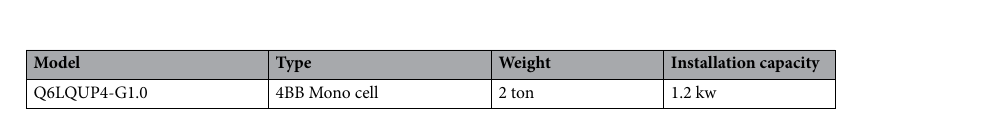
Table 1. Land use plan in environmental impact statement. The plant has an installed capacity of 40 MW, equipped with approximately 130,000 solar panels. Maximum Power Pmax (W) per panel (300 W): Standard Test Conditions, STC, a cell temperature of 25 °C, and irradiance of 1000 W/m 2 with an air mass of 1.5 spectra. Source: 2016, environmental impact statement for Youngwol solar power plant 16 .